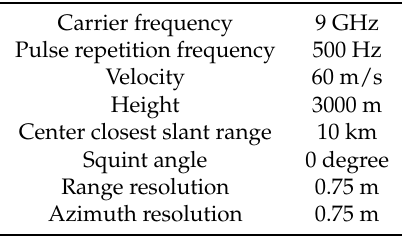
Table 8. X-Band SAR system parameters.